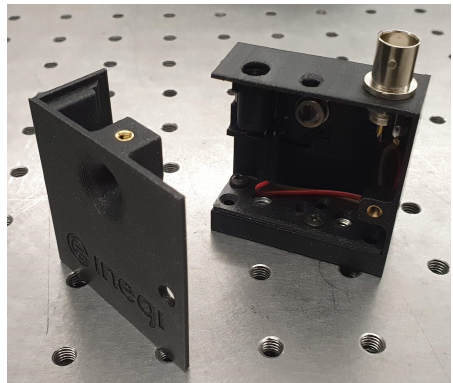
Figure 7. Custom photodetectors for laser-based triggering.